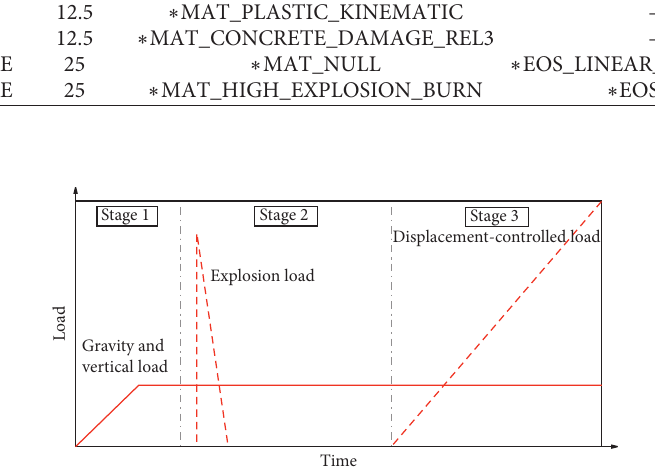
Figure 6: Three-stage loading